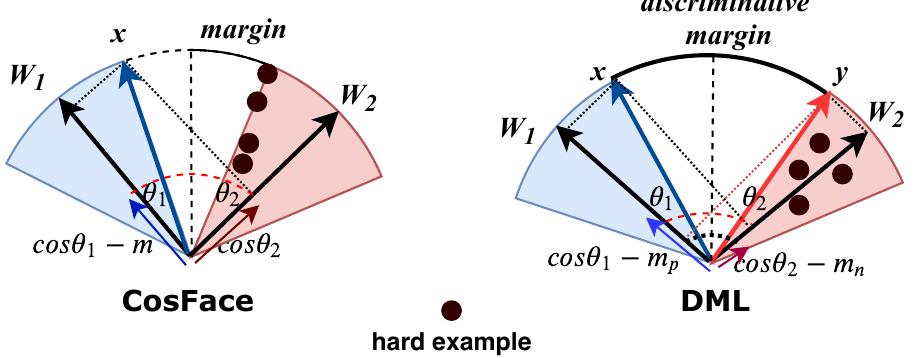
Figure 2. Geometrical interpretation of DML is illustrated from feature perspective. Blue and red areas represent the feature space of the positive and negative classes, respectively. The extracted feature vectors of the positive or negative image pairs are merged into a single vector at the feature level. CosFace [18] sets the same margin m for positive and negative classes, so the discrimination process cannot be strong enough. Compared to positive class margin m p , DML learns a larger margin m n for the negative class, consequently expands the variations between classes and condenses the variations within classes, implicitly optimizing the discrimination space. Negative pairs with small visual differences move closer to negative pairs with large visual differences, pushing hard examples into the feature space of the negative